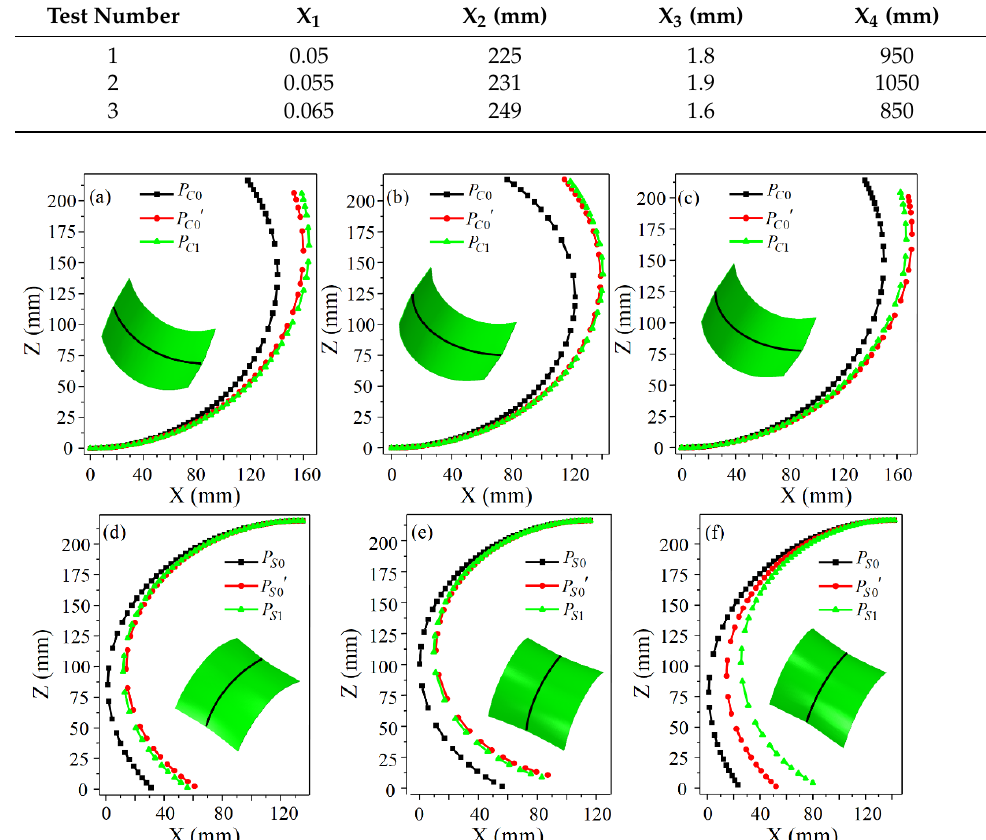
Figure 13. Comparison of the profiles of the longitudinal centerline: ( a ) Test 1—positive Gaussian curvature surface; ( b ) Test 2—positive Gaussian curvature surface; ( c ) Test 3—positive Gaussian curvature surface; ( d ) Test 1—negative Gaussian curvature surface; ( e ) Test 2—negative Gaussian curvature surface; ( f ) Test 3—negative Gaussian curvature surface. ′ P , P , and P 0 C 1 C 0 C